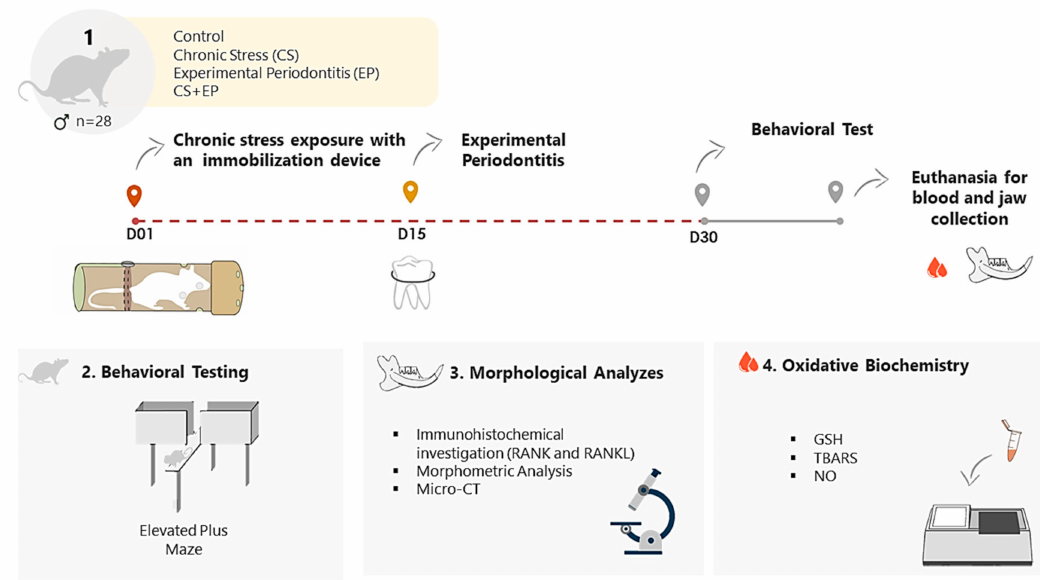
Figure 6. Methodological flow: (1) sample description and experimental steps; (2) elevated plus maze is the behavioral test adopted to investigate indirect parameters of chronic stress; (3) morphometric, microtomographic and immunohistochemical morphological analyzes in the hemi-mandibular bone. (4) Investigation of oxidative biochemistry determination of glutathione levels (GSH), lipid peroxidation (TBARS), nitric oxide (NO)